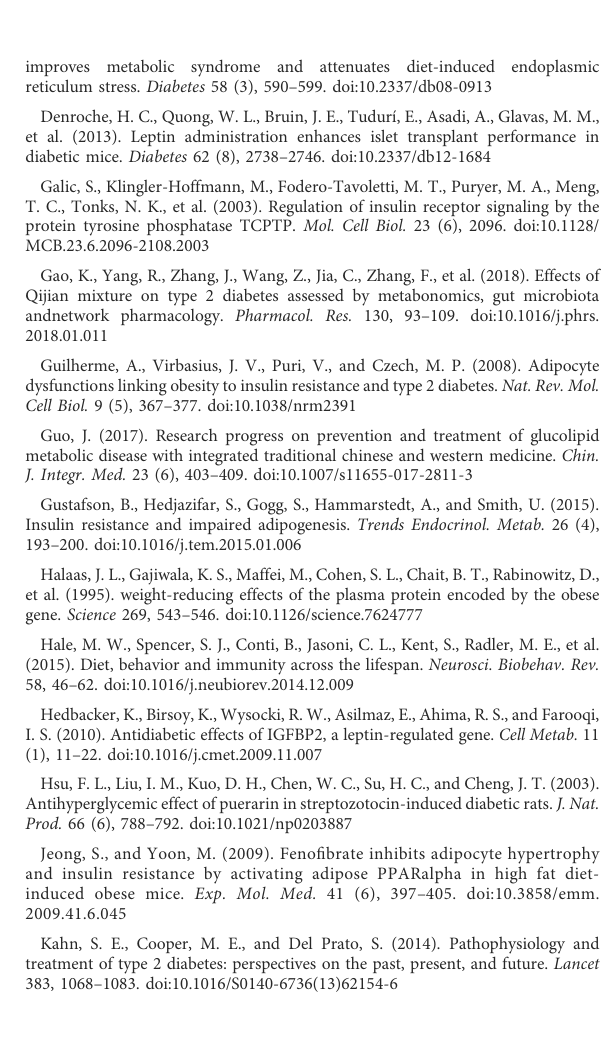
Representative hematoxylin and eosin staining of epididymal fat and subcutanoues fat after treatment with APF 16 weeks or APF+lepin 3